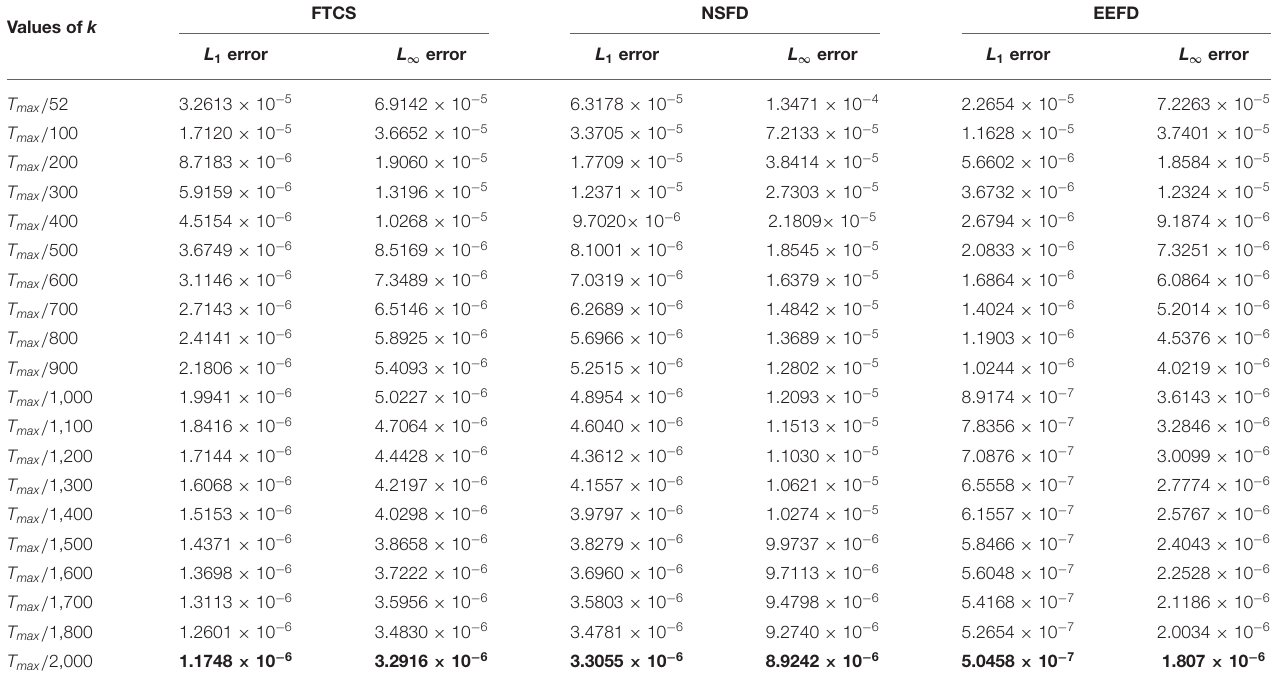
10 2 at time, T max =